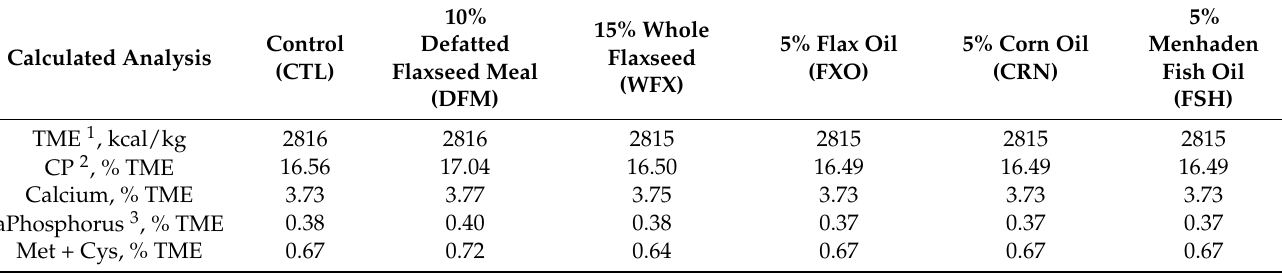
Table 4. Calculations of nutrient percentages and total energy of